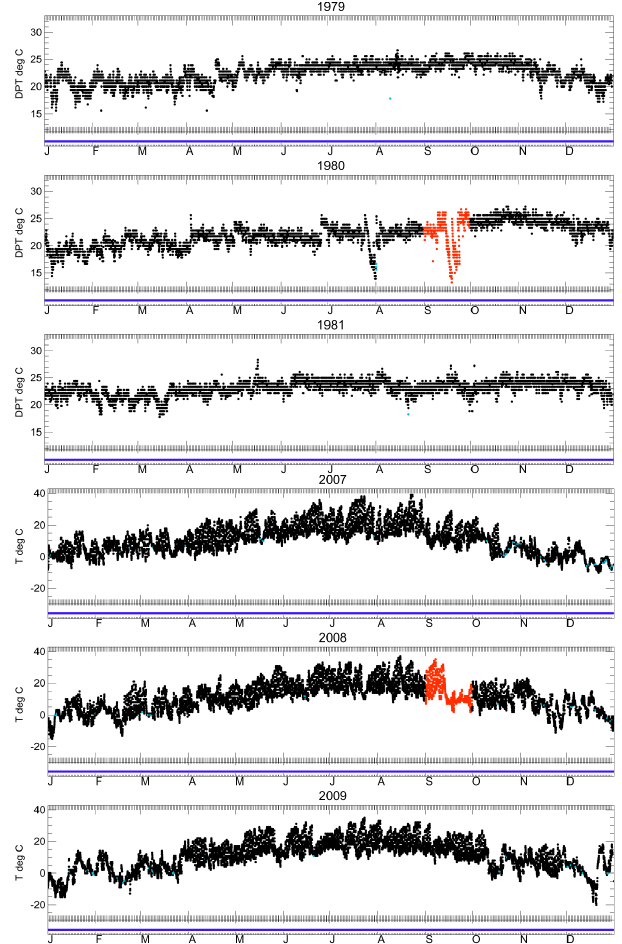
Fig. 13. Unusual variance check (test 13) for (top) 912180-99999 (13.57 ◦ N, 144.917 ◦ E, 162m, Andersen Air Force Base, Guam) for dewpoint temperature and (bottom) 133530-99999 (43.82 ◦ N, 18.33 ◦ E, 511m, Sarajevo, Bosnia-Herzegovina) for temperature. Red points show values removed by this test and blue points by other tests (none for the years and variables